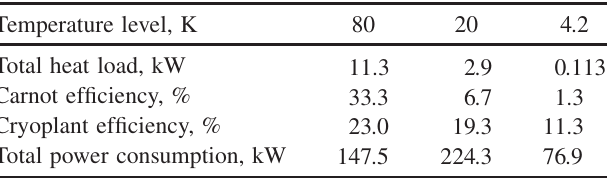
TABLE XI. Power consumption of the cryogenic plants at the different temperature levels. The total power consumption is around 450